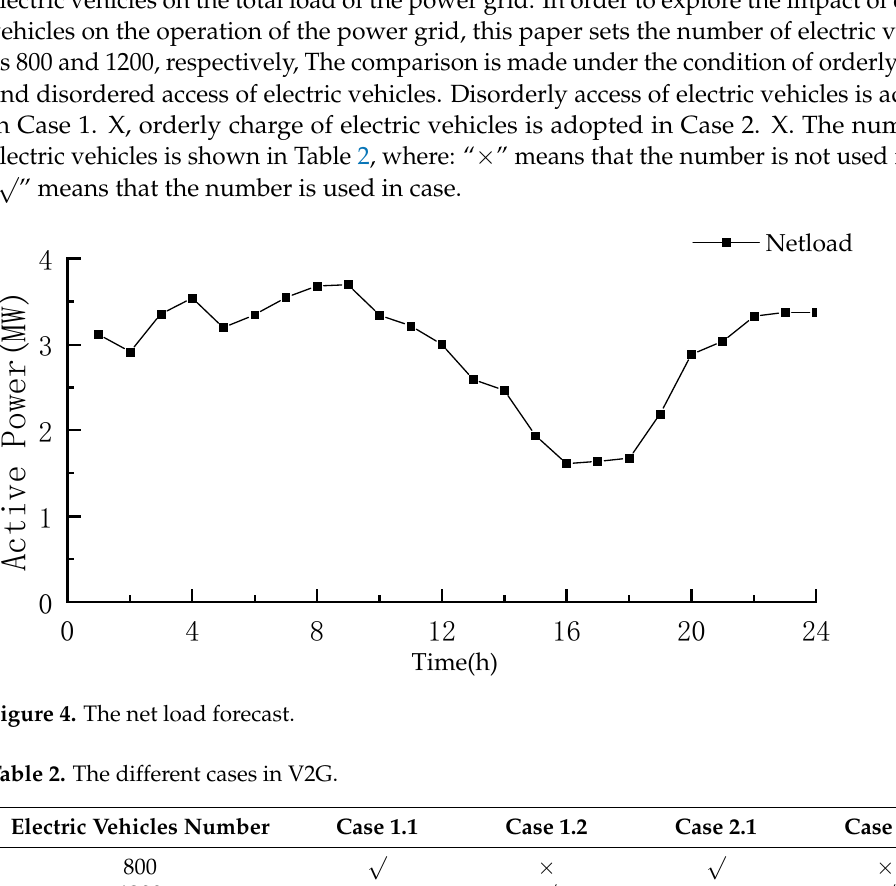
Table 2. The different cases in V2G.